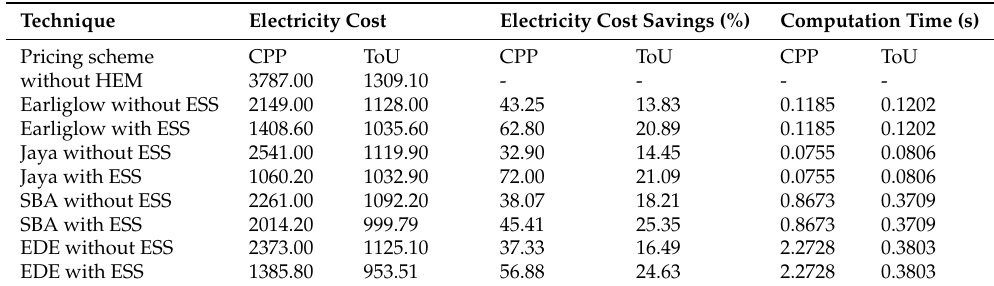
Table 4. Summary of the results for electricity cost in (cents).